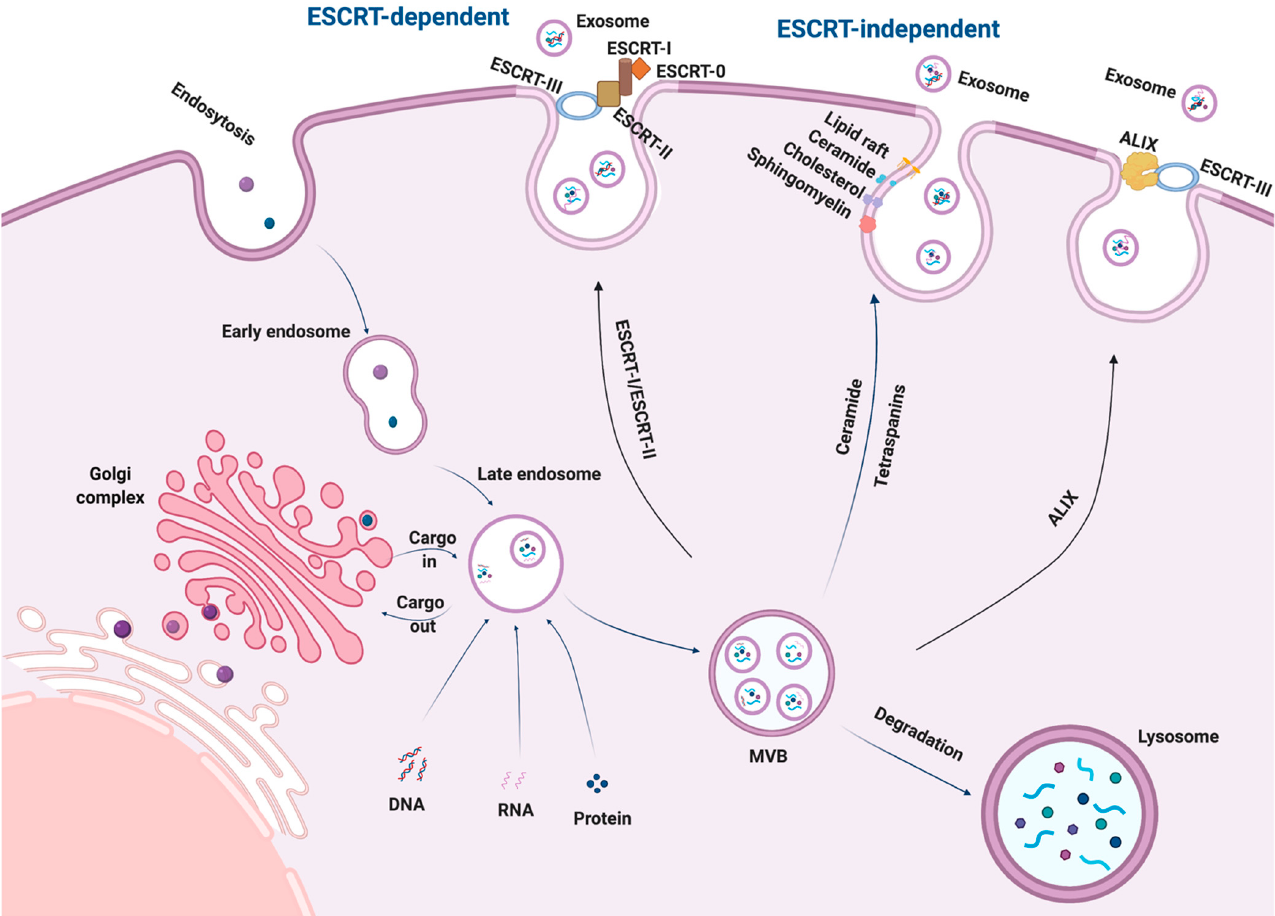
Figure 1. Biogenesis of exosomes.